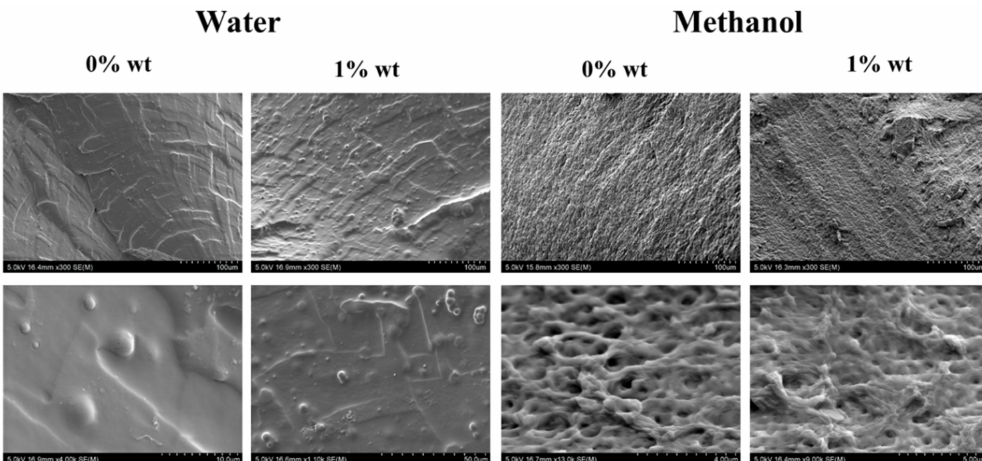
Figure 3. Representative SEM images of gels in the absence (0 wt%) and presence (1 wt%) of the lipopeptide. The top panel shows images taken at a magnification of 300 × and the bottom panel at a magnification of 1000 to 4000 × for the water samples and 9000 to 13,000 × for the methanol samples.